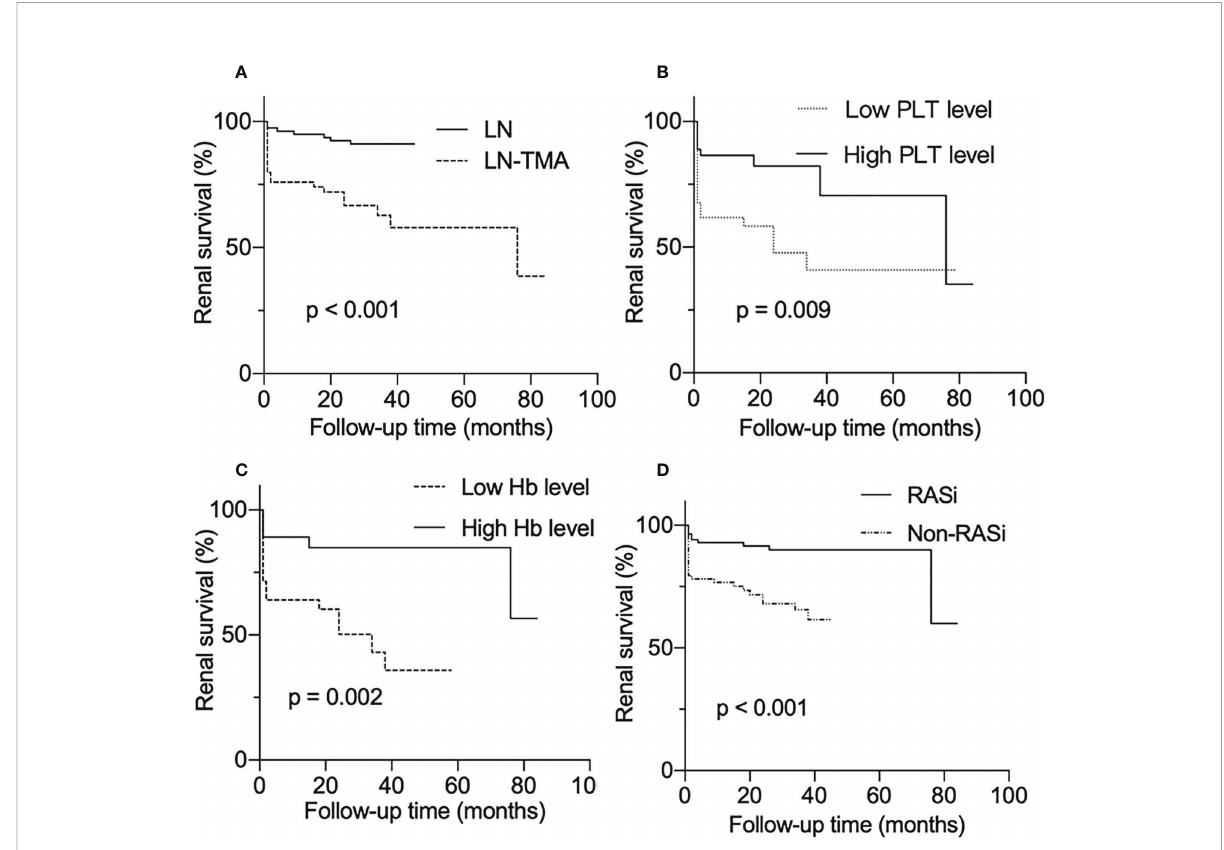
FIGURE 4 Renal survival rates of lupus nephritis patients. (A) With or without renal thrombotic microangiopathy among lupus nephritis patients. (B) Divided into low and high PLT level groups according to whether the platelet count is less than 100 × 10 9 /l among LN-TMA group. (C) TMA group was separated into low Hb and high Hb level according to whether Hb was less than 90g/l. (D) With or without RASi among LN patients.